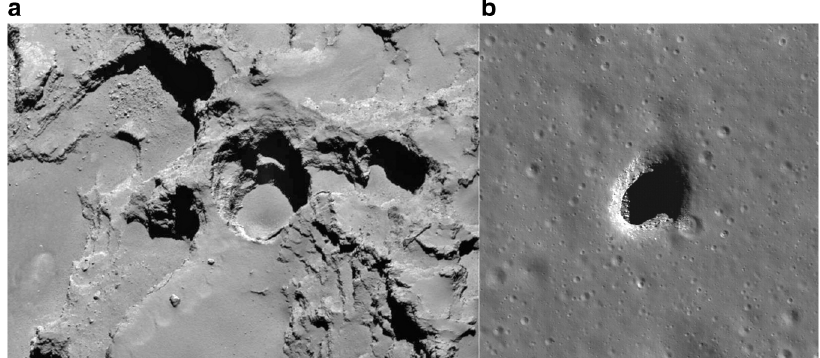
Fig. 2 Volatile-rich and igneous bodies have holes to their interiors that we can explore. a Sinkholes in comet 67P/Churyumov-Gerasimenko, where material has collapsed almost 200 m into voids associated with cometary activity (ESA/Rosetta/MPS). b One of the skylights discovered on the nearside volcanic plains of the Moon. This 130-m cave in Mare Ingenii probably formed when the roof of an underground lava tube collapsed